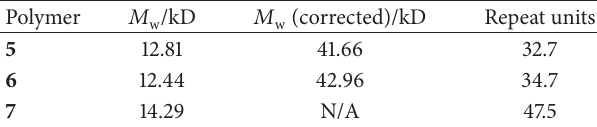
Table 1: GPC data on polymers 5 – 7 .